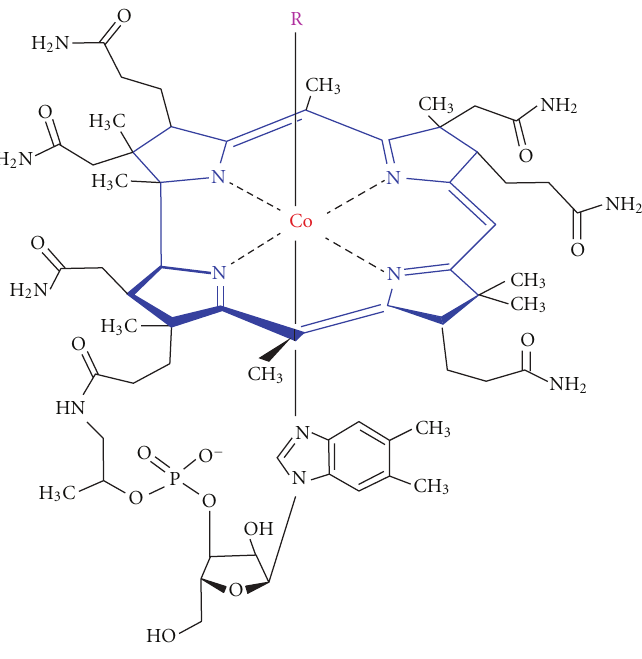
Figure 1: Structure of